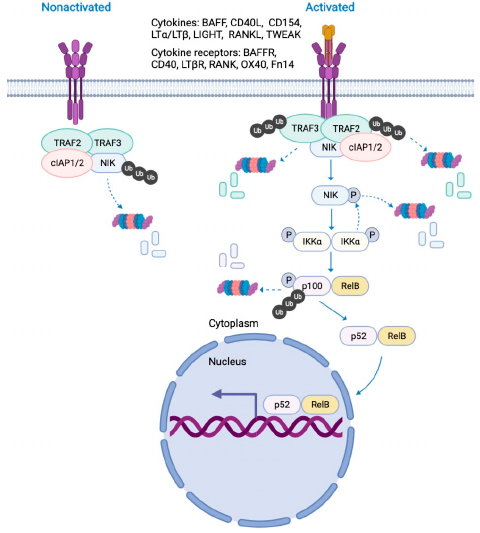
Figure 1. The non-canonical NF- κ B signaling pathway. Under physiological conditions, the non-canonical NF- κ B signaling pathway is inactivated because of the low levels of NIK protein, which is due to TRAF2-, TRAF3-, and cIAP1/2- mediated ubiquitination and degradation. Under stress or pathological conditions, elevated cytokines such as BAFF, CD40L, CD30L, LT α / β /LIGHT, OX40L, RANKL, and TWEAK bind to their receptors BAFFR, CD40, CD30, LT β R, OX40, RANK, and Fn14, respectively, which recruit TRAF2, TRAF3, and cIAP1/2, causing their ubiquitination and degradation. NIK protein levels are increased, and NIK phosphorylates IKK α and NF- κ B2, leading to p100- to p52- processing. p52 and RELB form heterodimers and enter the nucleus to perform their function by activating gene transcription. BAFF: B-cell-activating factor; CD40L: CD40 ligand; CD30L: CD30 ligand; LT α / β : lymphotoxin alpha/beta; OX40L: OX40 ligand; RANKL: receptor activator of NF- κ B ligand; TWEAK: tumor necrosis factor-like weak inducer of apoptosis; BAFFR: B-cell-activating factor receptor; LT β R: lymphotoxin beta receptor; RANK: receptor acti- vator of NF- κ B; Fn14: FGF-inducible 14; TRAF2: TNF-receptor associated factor 2; TRAF3: TNF-receptor associated factor 3;cIAP1/2: cellular inhibitor of apoptosis 1/2; Ub: ubiquitin; NIK: NF- κ B-inducing kinase; IKK α : inhibitory kappa B kinase alpha.